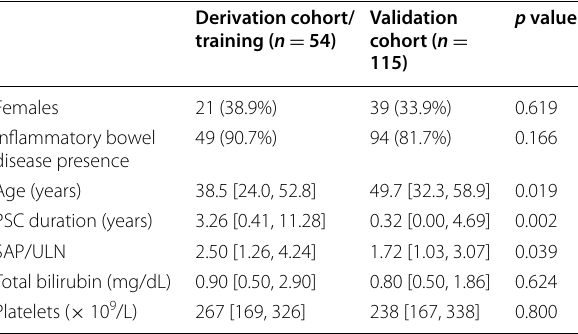
Data are given as median [interquartile range] with the exception of the number and percentage of females and of patients with inflammatory bowel disease. For some patients, the MRI/MRCP which established their diagnosis of PSC was used in this study. The date of the MRI used in the study was time zero or the baseline. Therefore, the duration of PSC for some subjects was 0 years MRI Magnetic resonance imaging, MRCP Magnetic resonance cholangiopancreatography, PSC Primary sclerosis cholangitis, SAP/ULN Serum alkaline phosphatase relative to the upper limit of normal within three months of the baseline magnetic resonance